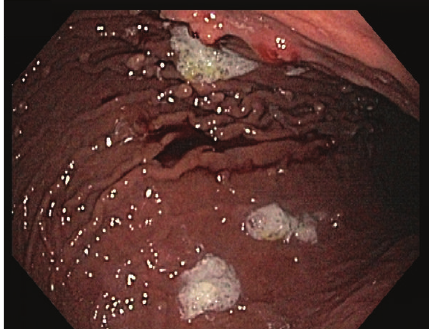
Figure 3: Upper endoscopy image following magnetic sphincter augmentation and cessation of all antacid medications showing minimal polyps that were biopsied and showed hyperplastic polyps.